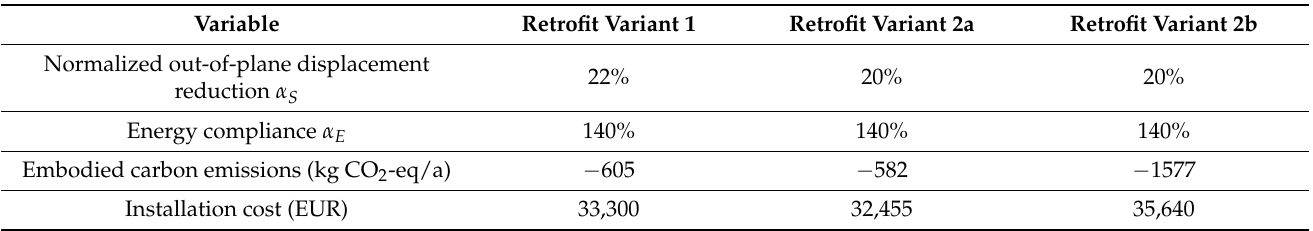
Table 4. Performance indicators for the three retrofit alternatives presented in this study.